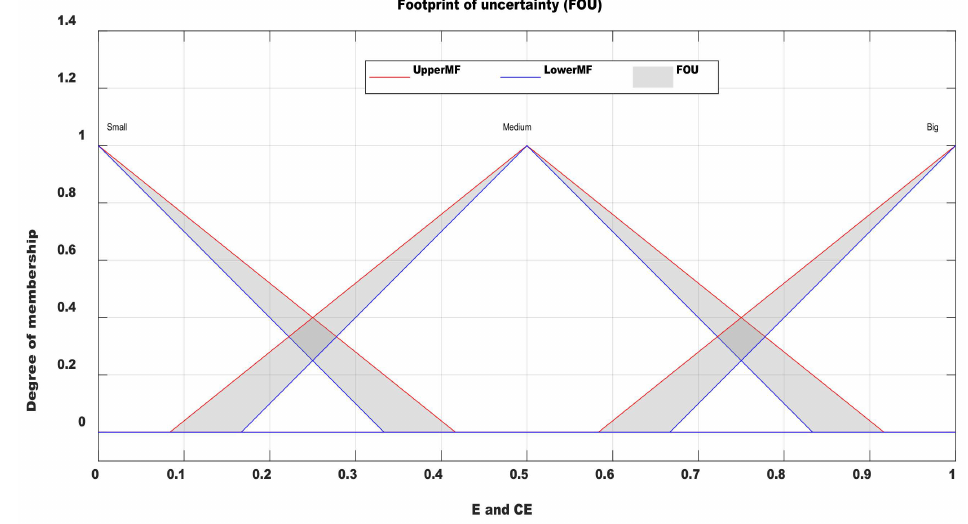
Figure 13. Input membership